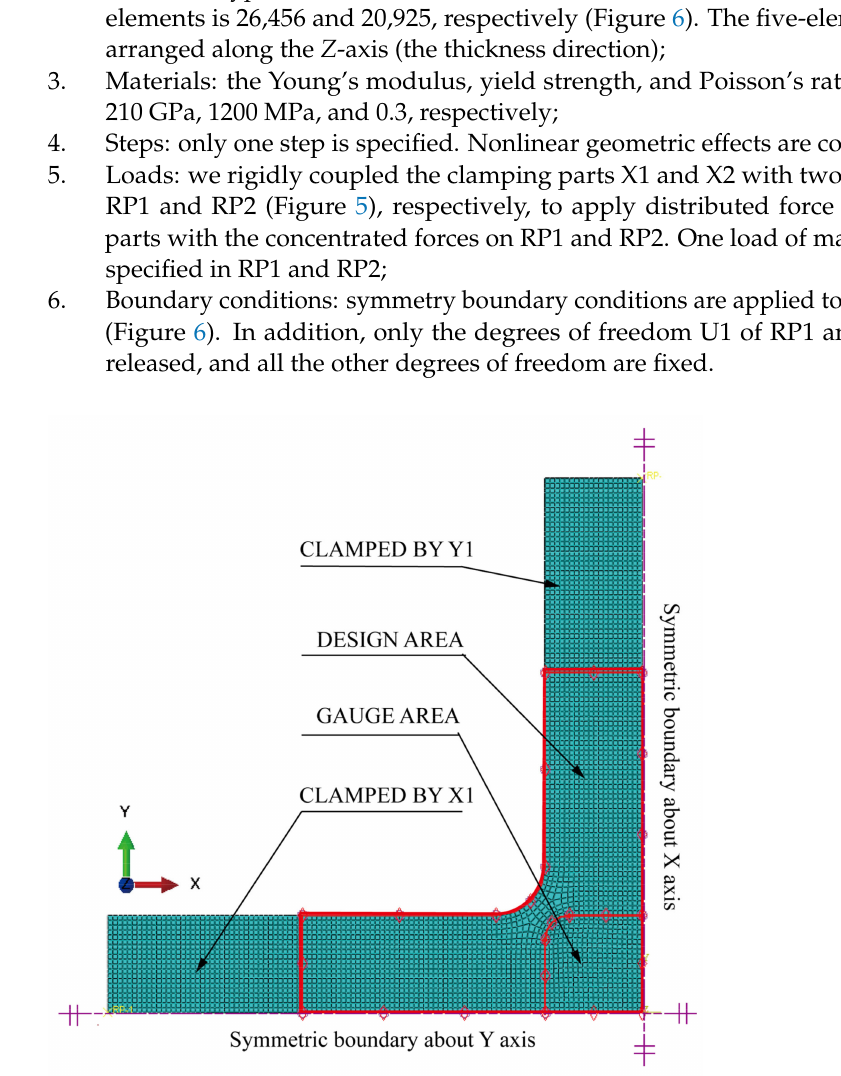
Figure 6. The finite element model for topology